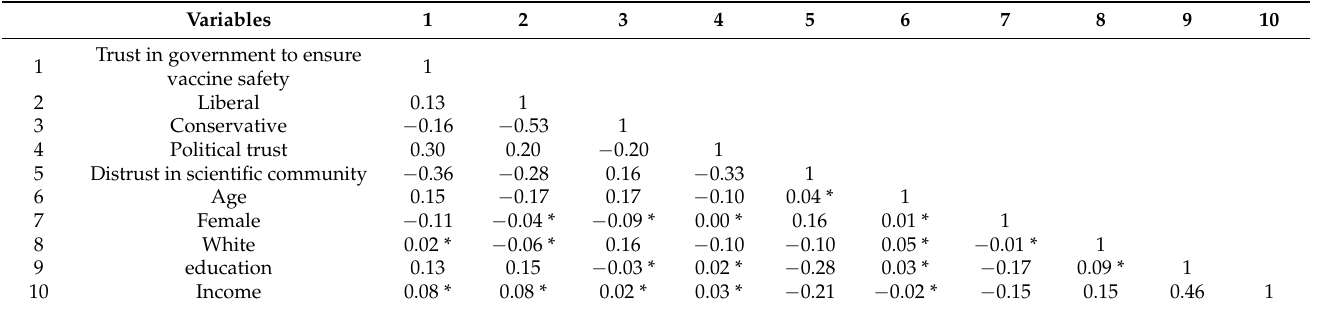
Table 2. Correlations between